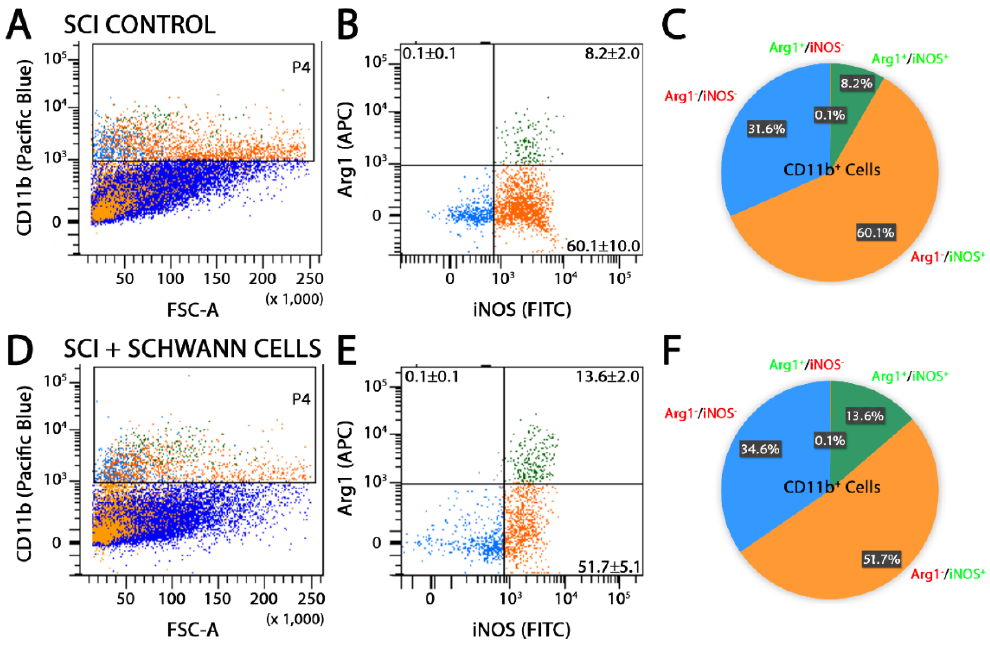
Figure 2. SC transplantation shifted the CD11b immune cell population from an Arg1 − iNOS + pro-inflammatory to an intermediate Arg1 + iNOS + phenotype after SCI. Representative images of flow cytometry analysis and pie charts of CD11b population dynamics at 14 days post-injury (7 days post-transplantation) show, compared with SCI controls ( A – C ), a decreased percentage of CD11b cells stained with Arg1 − iNOS + and an increased percentage for Arg1 + iNOS + in animals receiving SC transplants ( D – F ). Results are expressed as mean ± standard deviation (SD). Abbreviations on the graphs are: Fluorescein isothiocyanate (FITC), Allophycocyanin (APC) and Forward Scatter (FSC-A). For panels ( B , E ), the blue dots represent the CD11b population that is iNOS − -Arg1 − , the orange dots represent the CD11b population that is iNOS + -Arg1 − and the green dots represent the CD11b population that is double positive for both iNOS + -Arg1 + . These colored dots are also shown in the forward scatter plots of panels ( A , D ).